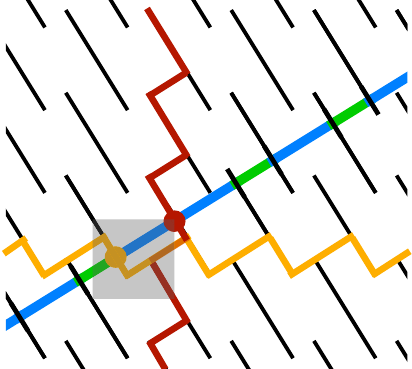
FIG. 4. Atomic surfaces (black lines) of a Fibonacci quasi- crystal. The vertices of the Fibonacci quasicrystal are determined by the intersection points of the physical space and the atomic surfaces. The blue and green regions are the long ( L ) and the short ( S ) tiles that tile the d ¼ 1 physical space. The yellow line is an S -type atomic surface associated to the yellow particle. The red line is an L -type atomic surface associated to the red